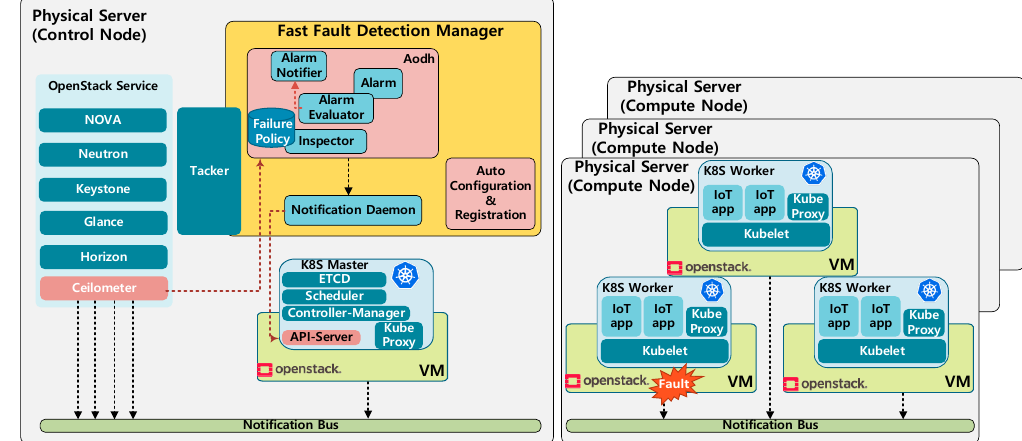
Figure 2. Proposed cloud architecture for fast fault detection.